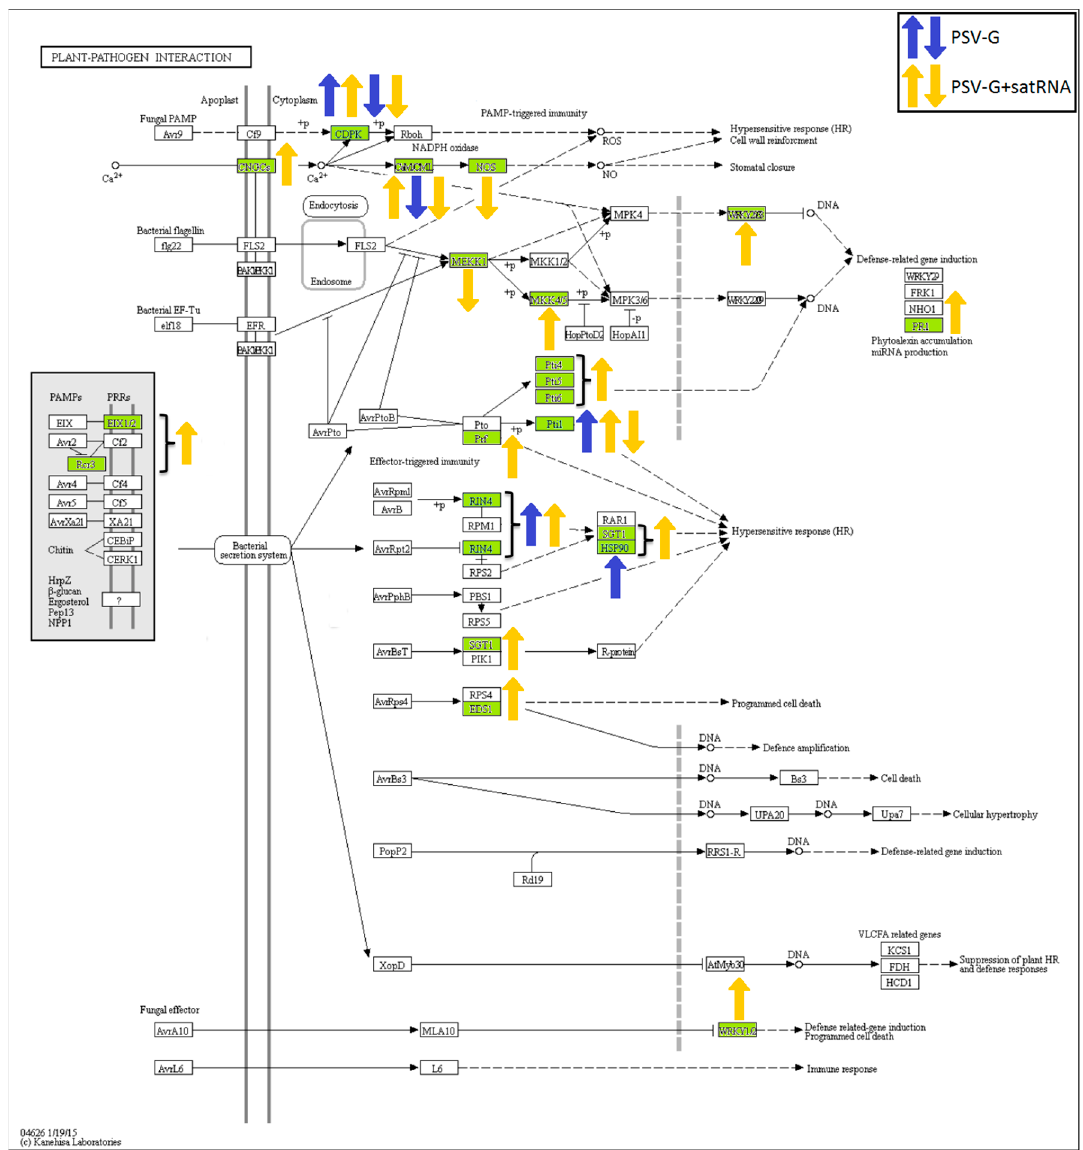
Figure 10. Differentially expressed genes (green) associated with plant–pathogen interaction in PSV and PSV + satRNA infected plants. Up- and down-regulated DEGs are marked with arrows. The results are visualized in KAAS [35].